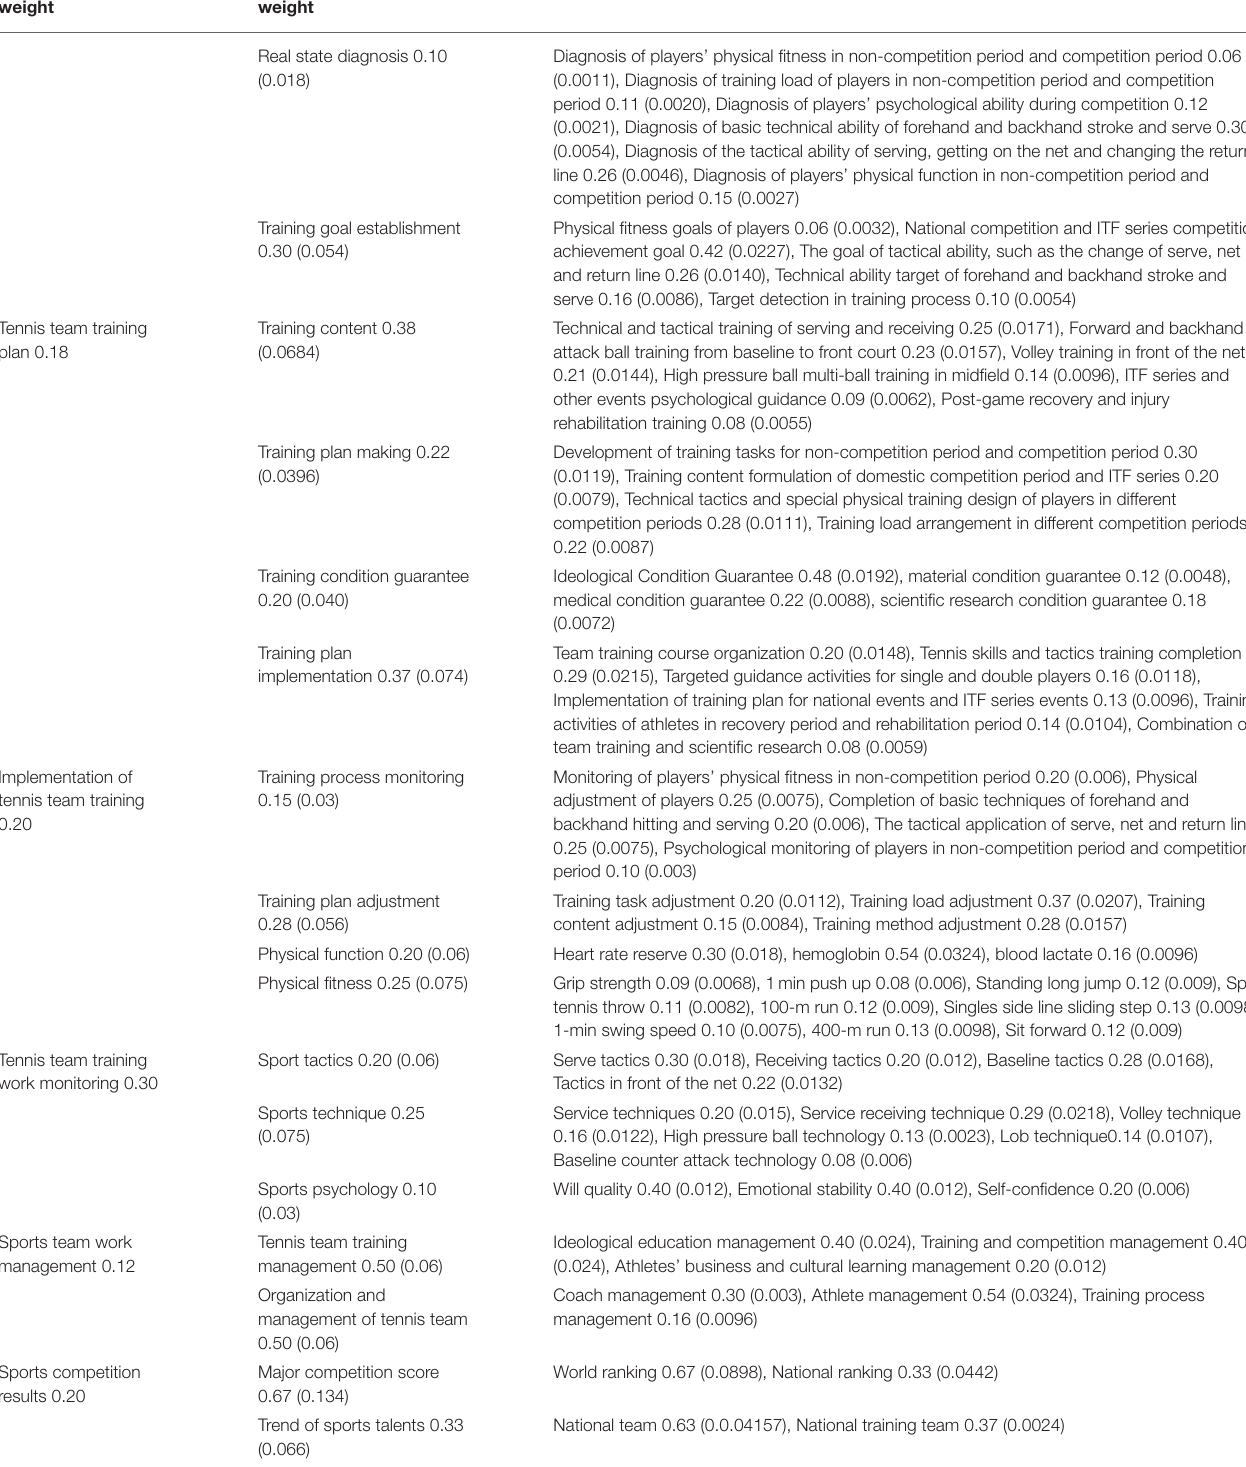
TABLE 16 | List of evaluation index system and weight of training quality of high-level tennis